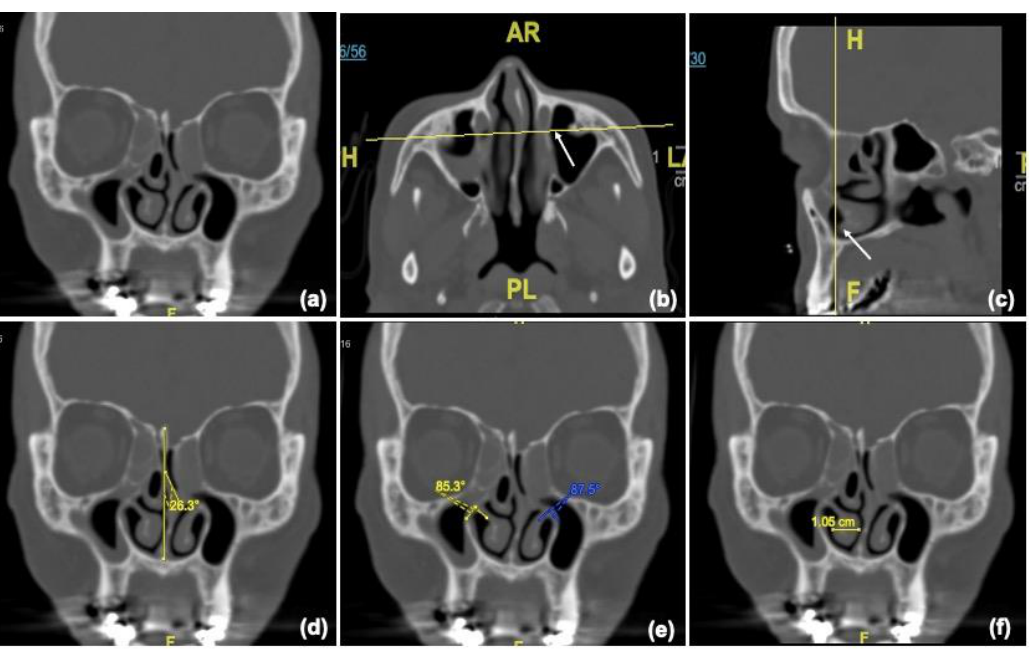
Figure 3. ( a ) Coronal sections corresponding to the most distal part of the BNLD were selected ( b ) from axial and ( c ) sagittal CT images. Measurements included NSD angle ( d ), angle between the bony inferior turbinate and medial wall of the maxillary sinus ( e ), and transverse mucosal thickness of the inferior turbinate ( f ).